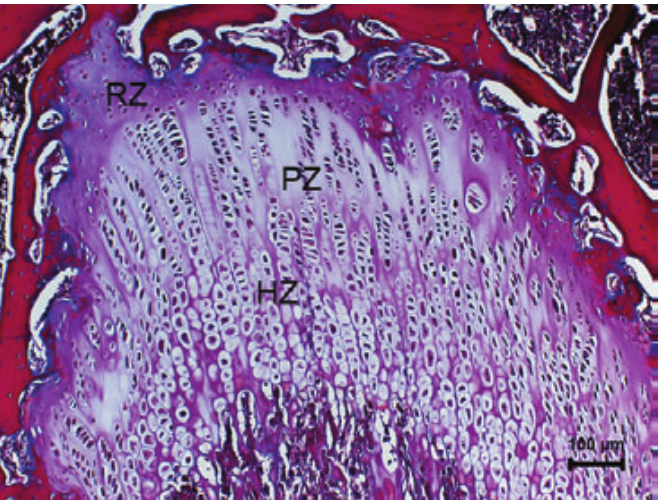
FIGURE 2 - Masson’s trichrome x 200. Photomicrograph of longitudinal section of distal growth plate of the rat femur after 21 days of laser irradiation. Resting zone (RZ), Proliferative zone (PZ), Hypertrophic zone (HZ).